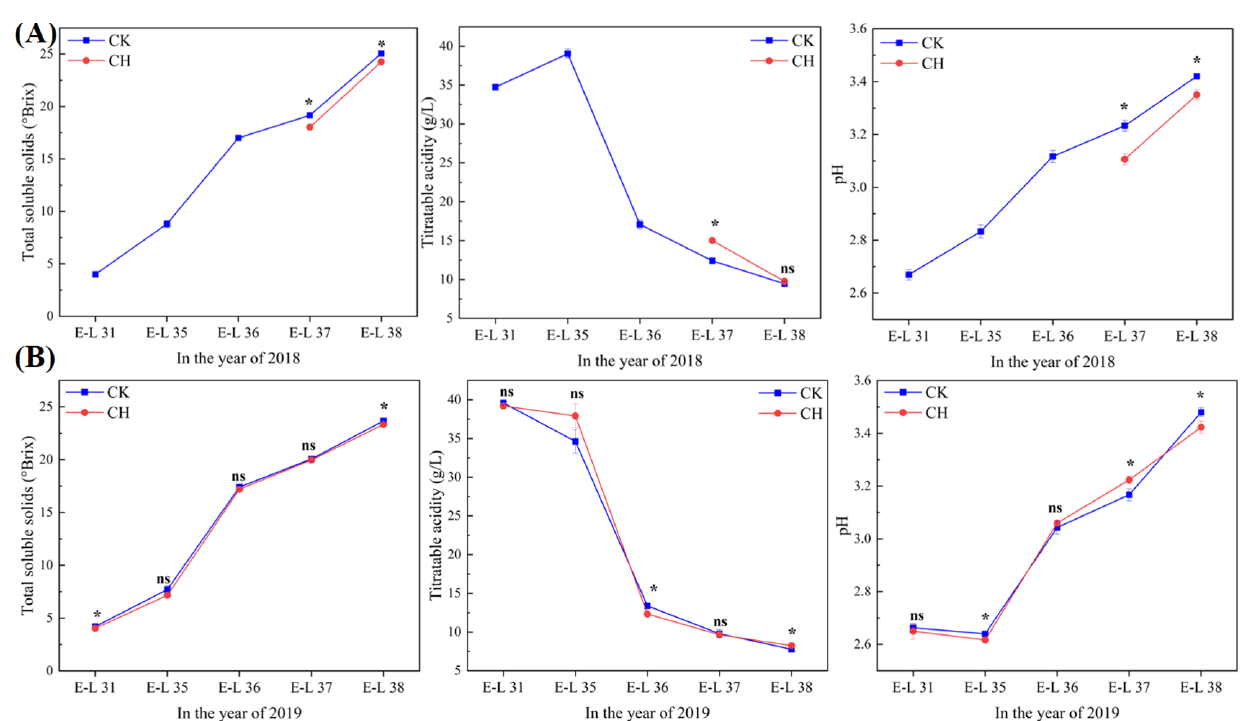
Figure 2. Effects of covering peanuts on the total soluble solids, titratable acidity and pH in 2018 ( A ), and in 2019 ( B ). Data are expressed as mean ± standard error ( n = 3). Different letters with each stage indicate the significant differences based on Duncan’s test at p < 0.05, and ns indicates no significant differences between treatments. CK: clean tillage; CH: covering peanuts.